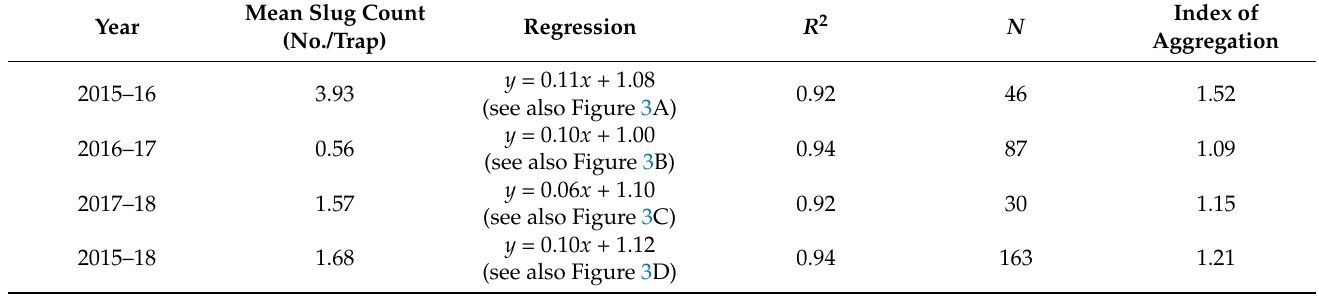
Table 2. The Taylor’s Power Law Index of Aggregation for individual years of the study, and for all three years combined. Mean slug catches of refuge traps (No. per trap), regression equation and R 2 values for the relationship between log (variance) vs. log (mean) calculated from x trap count and variance for each assessment date in each field.